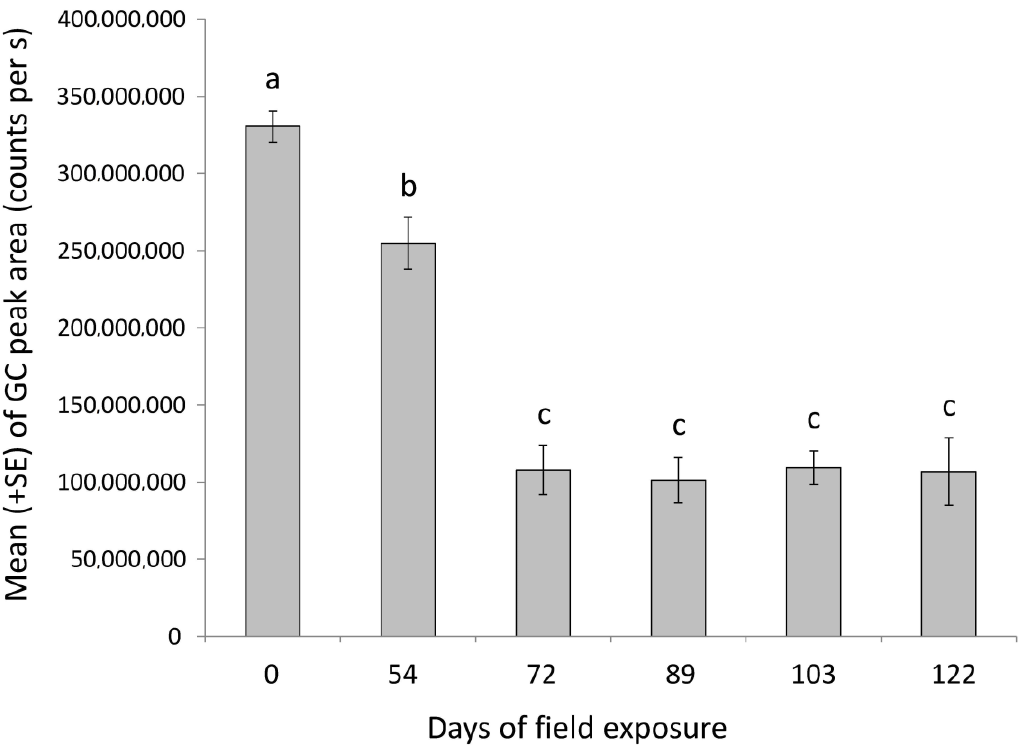
Figure 5. Mean (+SE) release rates of Grapholyta funebrana pheromone from dispensers measured by collecting the volatiles, by using the SPME headspace method at 22 °C. No letter in common indicates significant differences for p < 0.05 (ANOVA followed by Tukey’s HSD test).